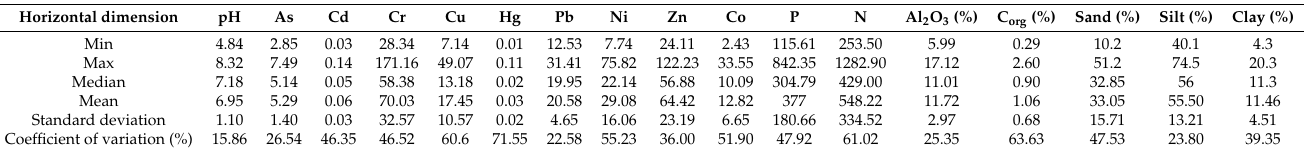
Table 2. A statistical summary of physico-chemical properties and heavy metal concentration of sediments